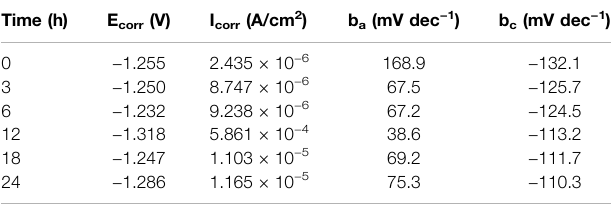
TABLE 3 | The fi tting calculation results for linear polarization zone of polarization curves.